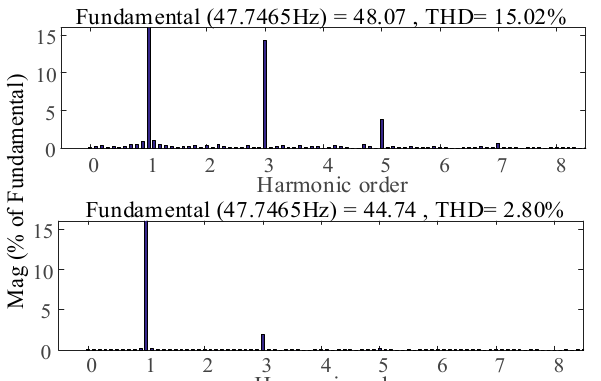
Figure 11. Harmonics analysis of phase a current under the two kinds of current control.